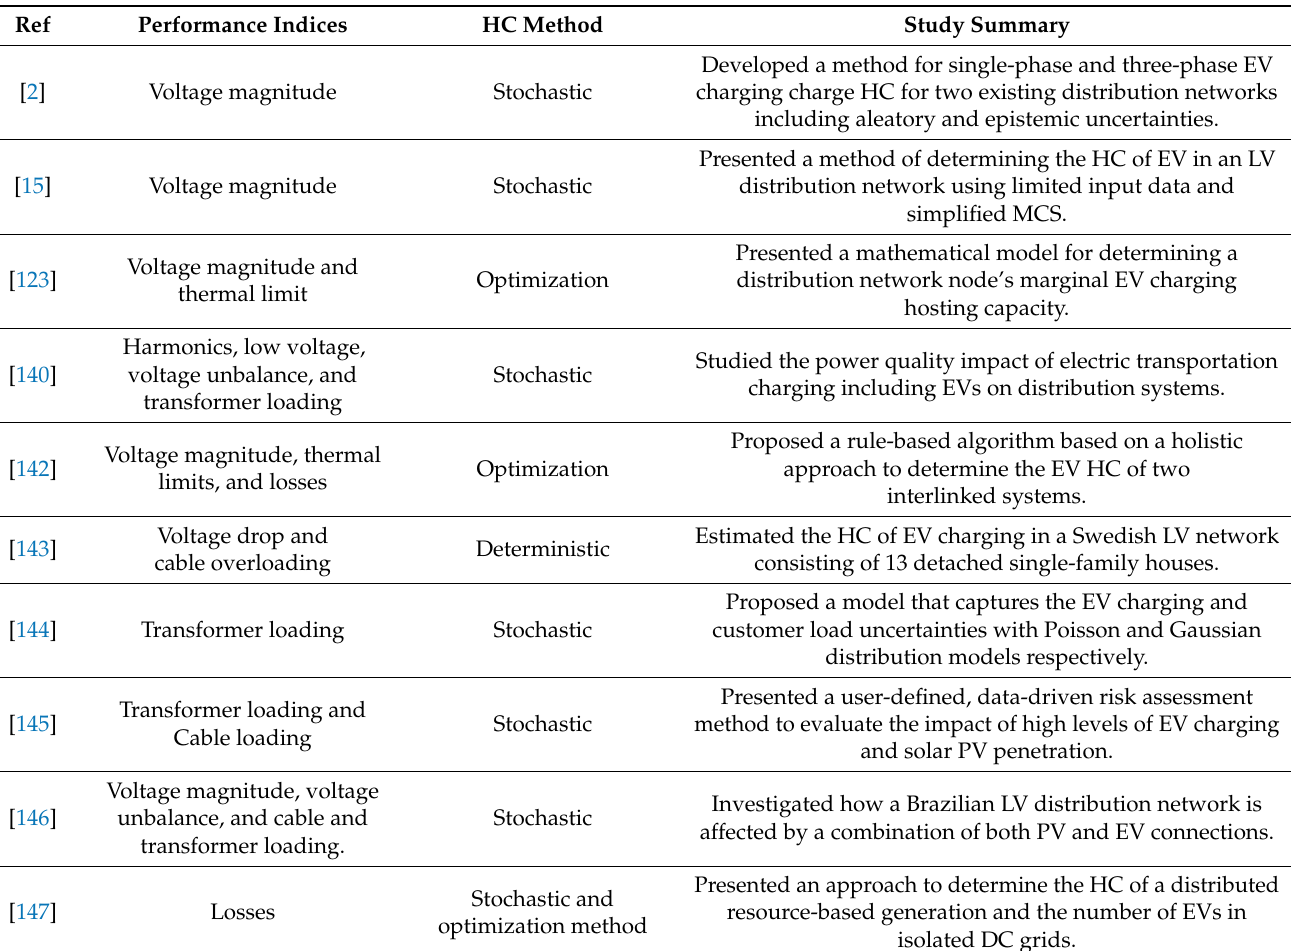
Table 8. Summary of EV charging HC studies highlighting the method and performance